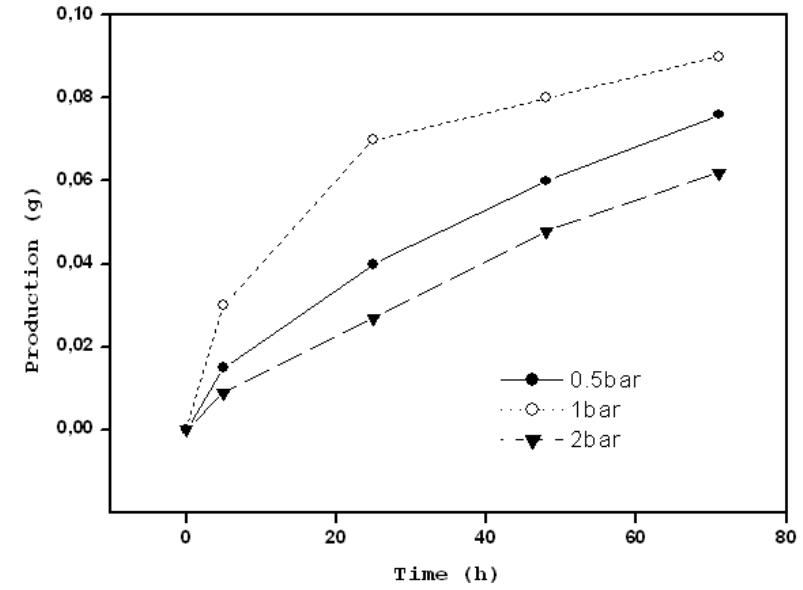
Figure 7. Separation of the D - and L -serine by the MIPCM from Ser racemate as a function of operating time as the operating pressure was varied from 0.5 to 2